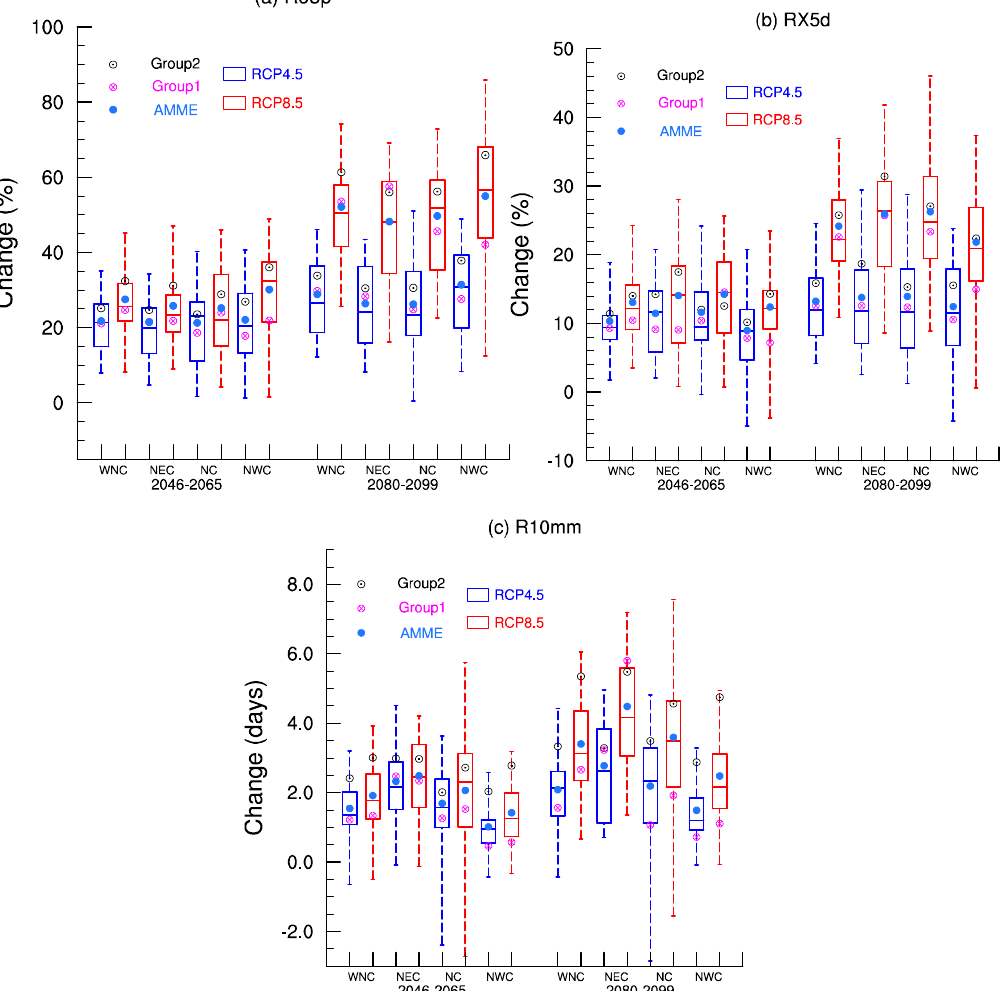
Figure 8. Box-and-whisker plot for projected changes (%) of three extreme rainfall indices including ( a ) R95p, ( b ) RX5d, and ( c ) R10mm form AMME during the middle of the century (2046–2065) and the end of the 21st century (2080–2099) relative to the reference period (1986–2005) under RCP 4.5 (blue) and RCP8.5 (red). The Group 1, Group 2, and AMME multi-model ensemble means are indicated by the purple, black, and blue dots.